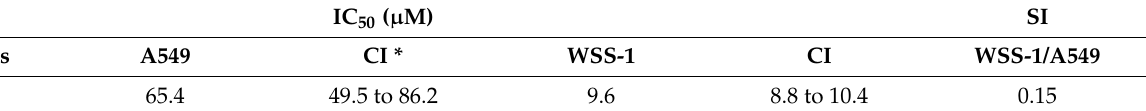
Figure 3. Screening of imatinib and its derivatives 2a-e and 3a-e at a concentration of 10 µM against human cell lines A549 (purple) and WSS-1 (green). Bars represent the mean ± standard deviation. Table 2 shows the IC 50 and SI values of imatinib and its most cytotoxic analogs ( 3a , 3c and 3d ) in A549 cells. Table 2. Cytotoxic activity and selectivity index of imatinib and derivatives 3a , 3c and 3d in the A549 and WSS-1 cells.